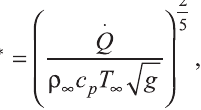
Figure 4 presented the vertical temperature next to the inner pane with above seven different grid sizes in Table 2. Along with refining the mesh, the temperature curve trended to be uniform. Results of the cases No. B5, B6 and B7 got slightly differences, and there was no sig- nificant improvement but more time consuming when the mesh density increased up to 10 grids/m. Therefore, we chose a mesh with the grid size of 0.10 m (10 grids/m) for the 1 MW fire in DSF1.